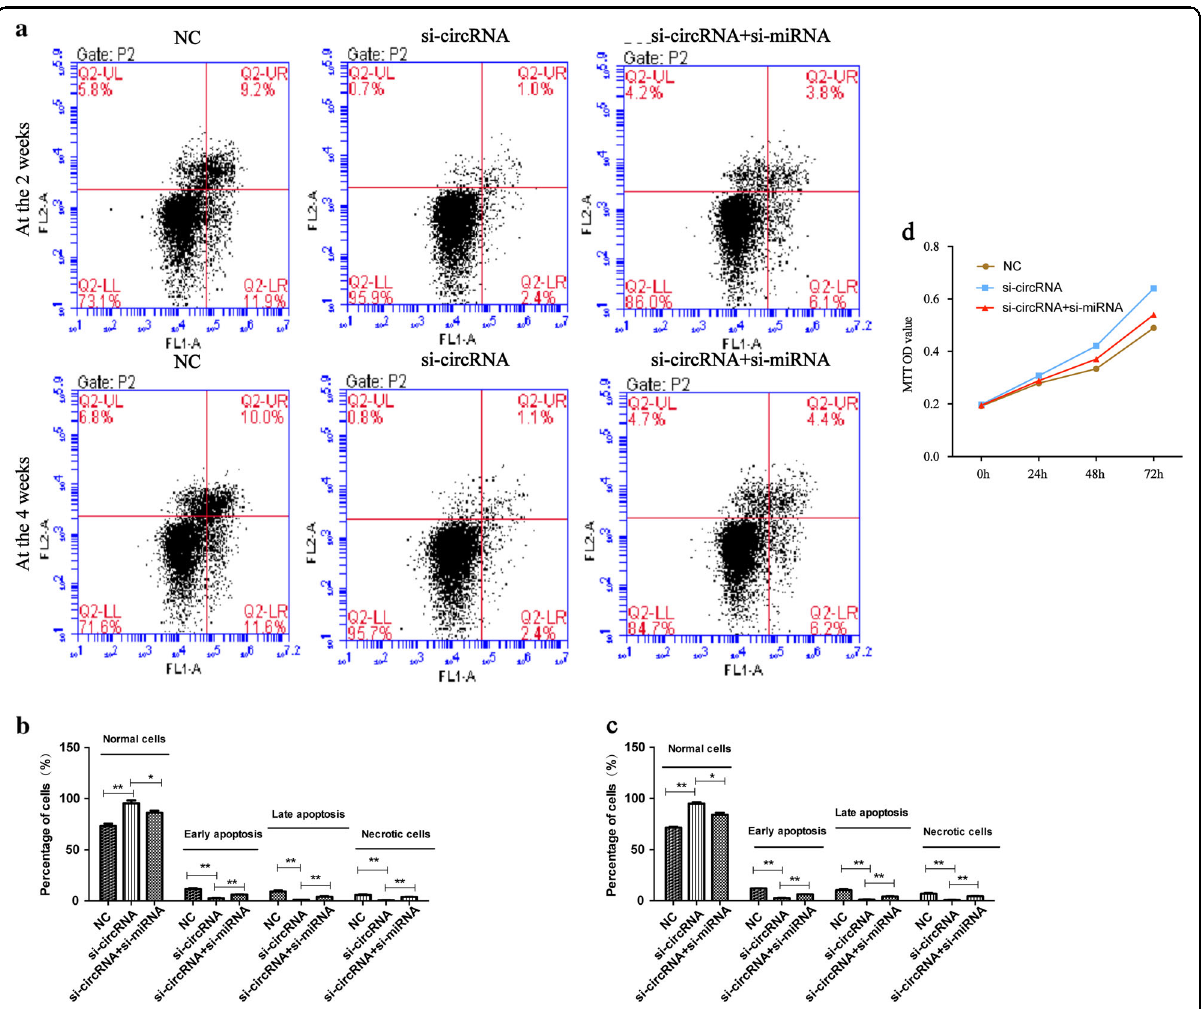
Fig. 4 circRNA_104670 promotes apoptosis and inhibits the proliferation of NP cells. a – c Cell fl ow cytometry was carried out to explore the NP cell viability at 2 and 4 weeks after the si-miRNAs were co-transfected into NP cells. The plots shown on the button left indicate normal NP cells, the plots shown on the bottom right indicate early apoptotic NP cells, the plots shown on the top right indicate late apoptotic NP cells and the plots shown on the top left indicate necrotic NP cells. d An MTT assay was performed in NP cells at 0, 24, 48, and 72 h after transfections. * p < 0.05; ** p <